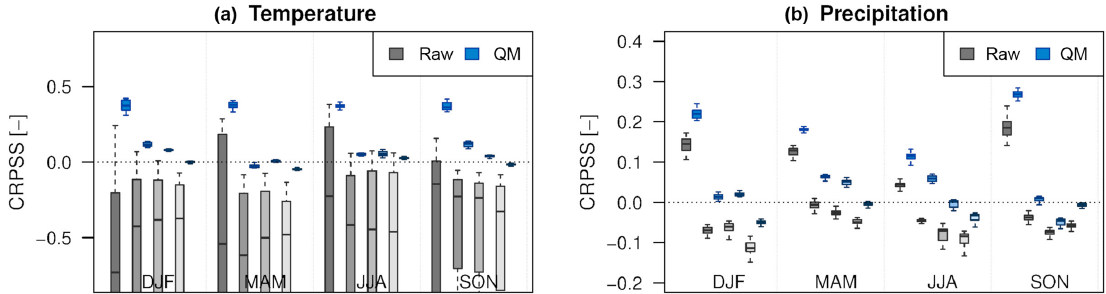
Figure 3. Overview of the CRPSS for weekly mean temperatures (a) and weekly precipitation sums (b) in 1994–2014 reforecasts grouped by season (DJF, MAM, JJA and SON) for all grid points within the Verzasca catchment. The shading of the boxes denotes lead time, where week 1 corresponds to day 5–11, week 2 to days 12–18 and so on. Grey shading for raw forecast and blue shading for pre-processed reforecasts. An individual box shows the distribution of the CRPSS for all grid points within the catchment averaged over all 13 reforecast initialization dates within one season. The boxes depict the interquartile range, the mean is indicated by the horizontal line and the whiskers span the length of 1 . 5 × standard deviation of the data. A perfect forecast has CRPSS = 1, and positive values indicate better skill than the reference